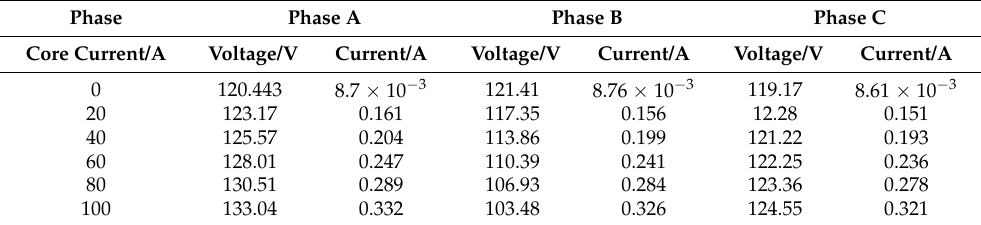
Table 9. Simulation value of induced voltage and calculating current of metal sheath with a common sheath protector when there are four